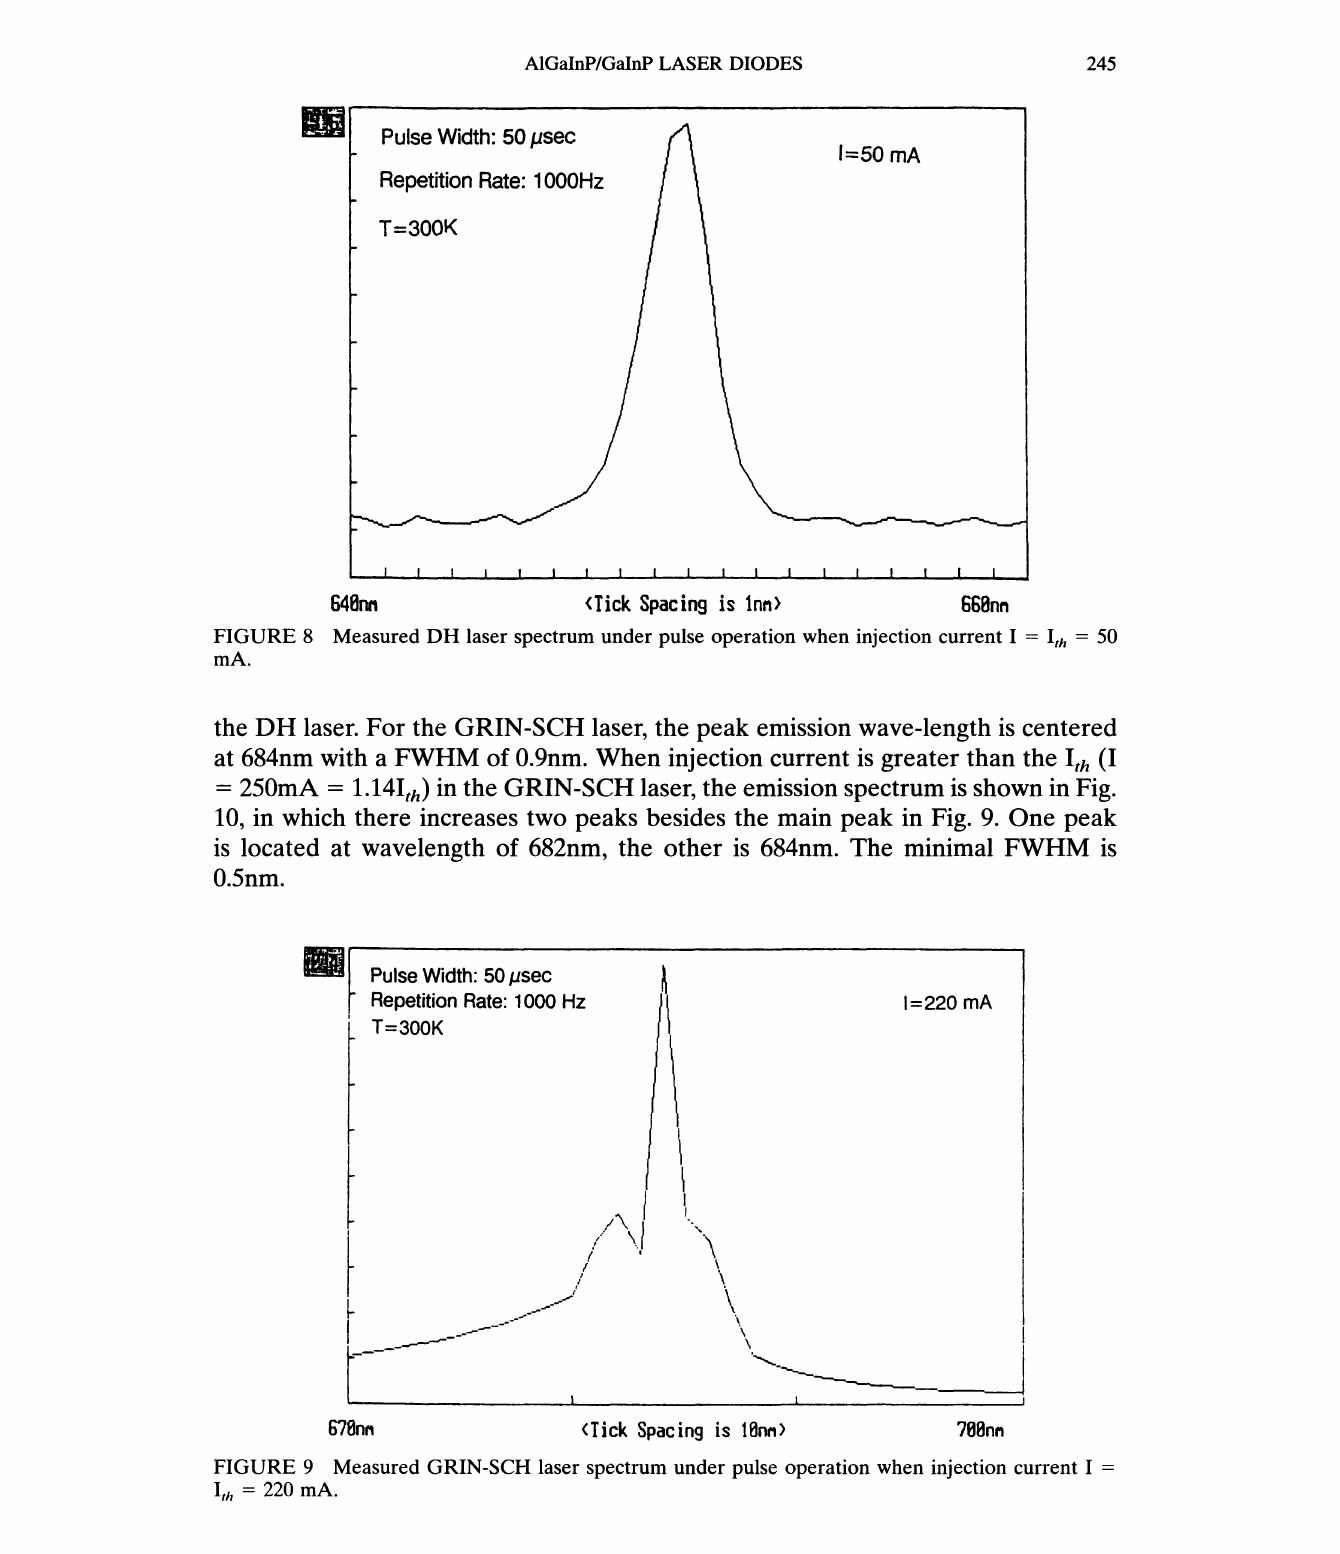
FIGURE 9 Measured GRIN-SCH laser spectrum under pulse operation when injection current I,h 220